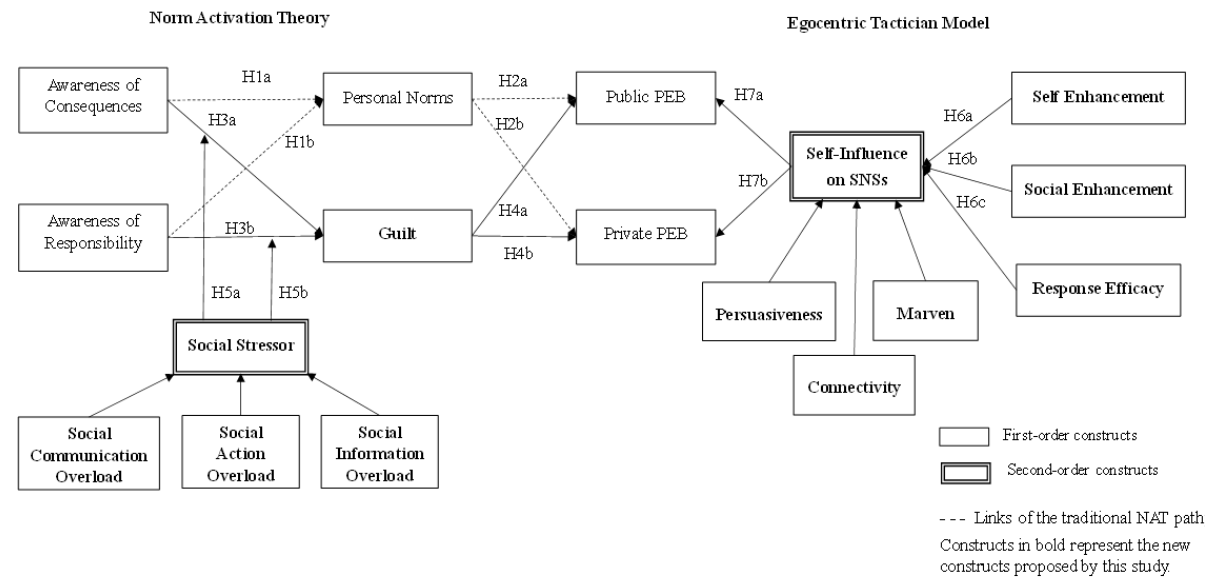
Figure 1. Research